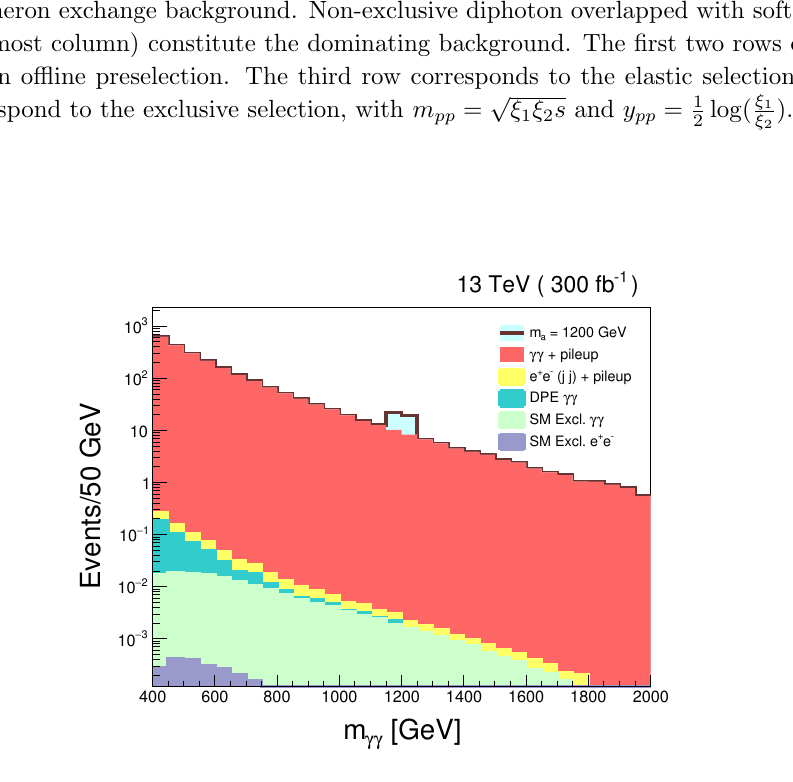
Figure 4 . Di(cid:11)erential yield as a function of the photon pair invariant mass for exclusive diphoton candidates with two tagged protons within the acceptance 0 : 015 < (cid:24) 1 ; 2 < 0 : 15. No elastic or exclusive o(cid:15)ine selection is applied for the diphoton candidates in this plot. We assume there are in average 50 secondary interactions per bunch crossing. For illustrative purposes, we show an instance of a resonant ALP production with m a = 1200 GeV and a coupling value f (cid:0) 1 = 0 : 1 TeV (cid:0) 1 .